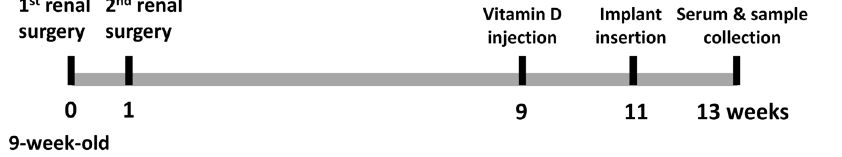
Figure 1. Illustration of the workflow. 1 st renal surgery: electrocautery of the left kidney; 2 nd renal surgery: a total nephrectomy of the right kidney; Vitamin D injections started at 9 th week (100ng/kg body weight, 3 times a week for 4